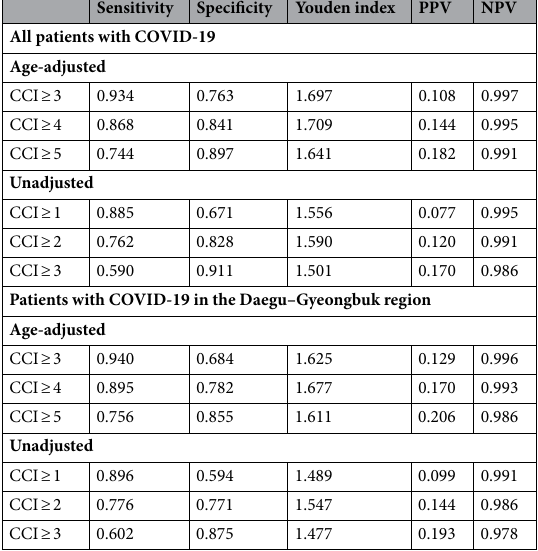
Table 2. Sensitivity and specificity of the Charlson comorbidity index (CCI) in predicting mortality among patients with coronavirus disease (COVID-19). PPV positive predictive value, NPV negative predictive value.